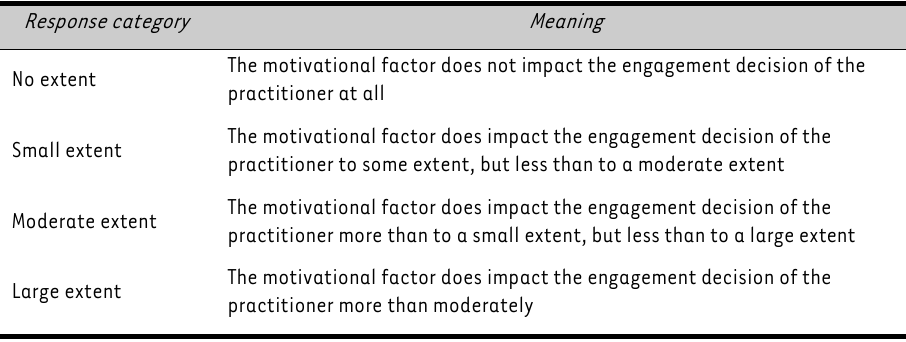
TABLE 2: Response categories of the questionnaire Response